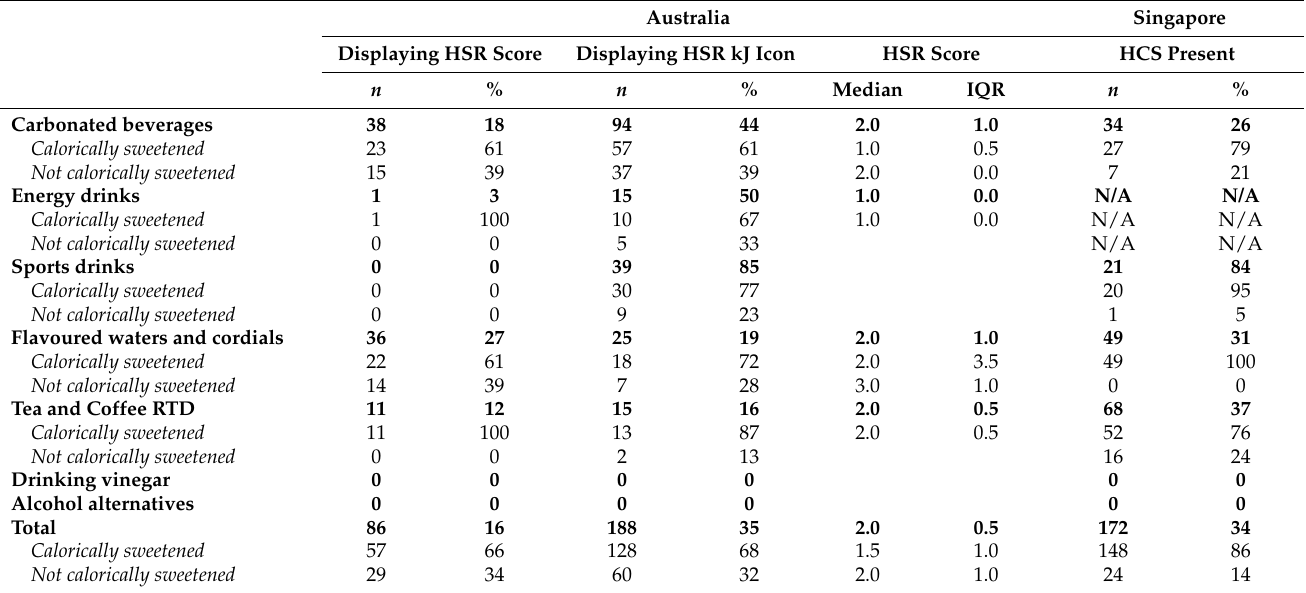
Table 5. Presence of symbols (Health Star Rating and Healthier Choice Symbol) displayed on the fronts of packs of beverages within each category and subcategory in Australia (2019) and Singapore (2020).